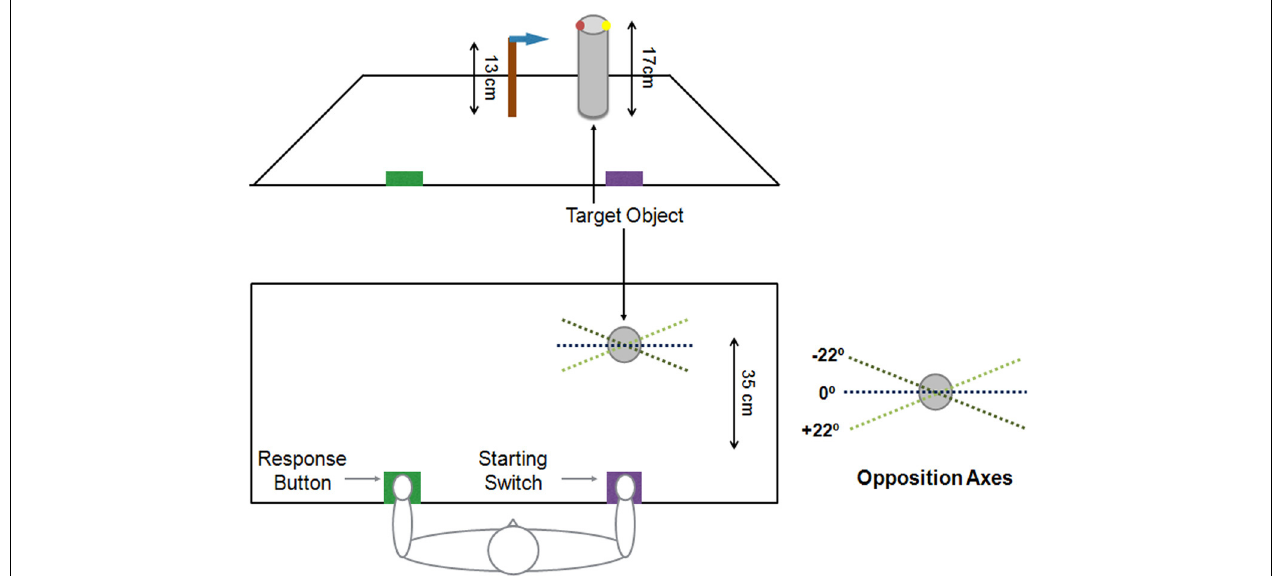
FIGURE 1 | Schematic representation of the experimental set up from the subject’s point of view (upper panel) and from above (lower panel). Subjects placed their right hand on a starting switch (purple) and the left hand on a response button (green). The target object was a cylinder, located 35cm from the starting point. On its upper side were